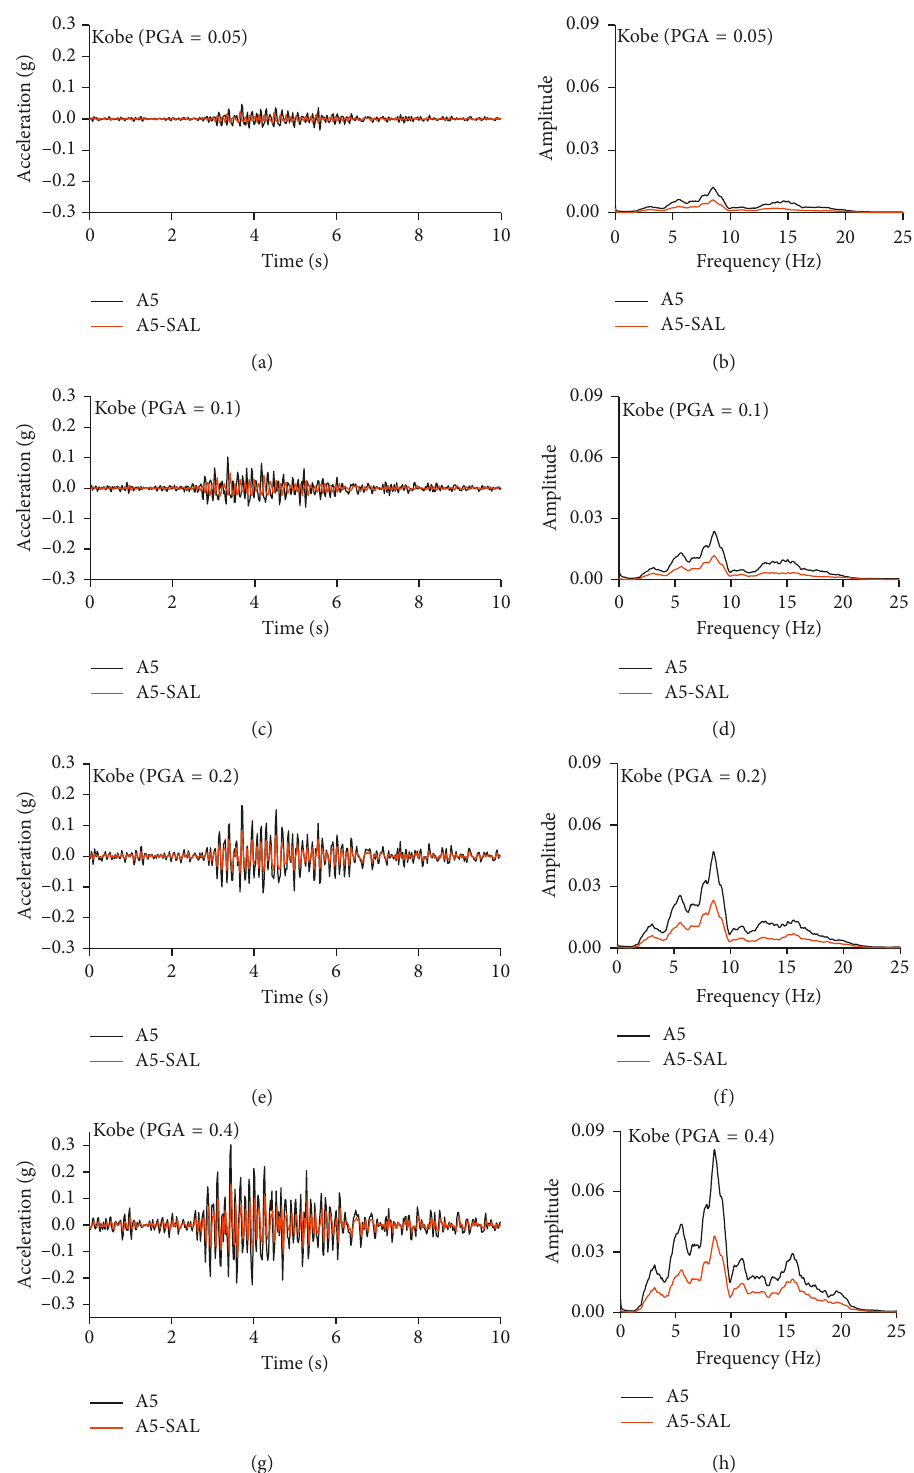
Figure 11: Comparison between results acceleration time history and corresponding spectrum of with and without SAL tests for A5 subjected to the Kobe with peak acceleration levels. (a) and (b) Peak acceleration Peak acceleration 0.2g. (g) and (h) Peak acceleration (cid:31)